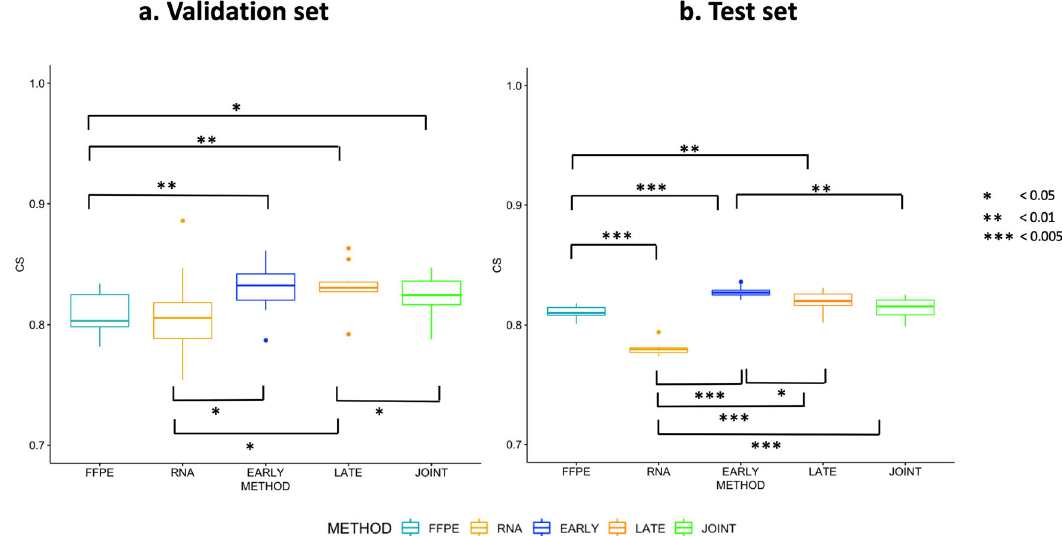
Fig. 5 Boxplots of model performance for each model strategy on the adult glioma cohort. a Composite Score (CS) distribution on cross-validation (CV) validation sets ( N = 63). b CS distribution of each CV fold on the test set ( N = 156). (* P value <0.05, ** P value <0.01 and *** P value <0.005; pairwise Wilcoxon signed-rank test). Table 2 Results of survival predictions on the independent Clinical Proteomic Tumor Analysis Consortium (CPTAC) cohort using the models trained on the adult The Cancer Genome Atlas (TCGA) cohort.